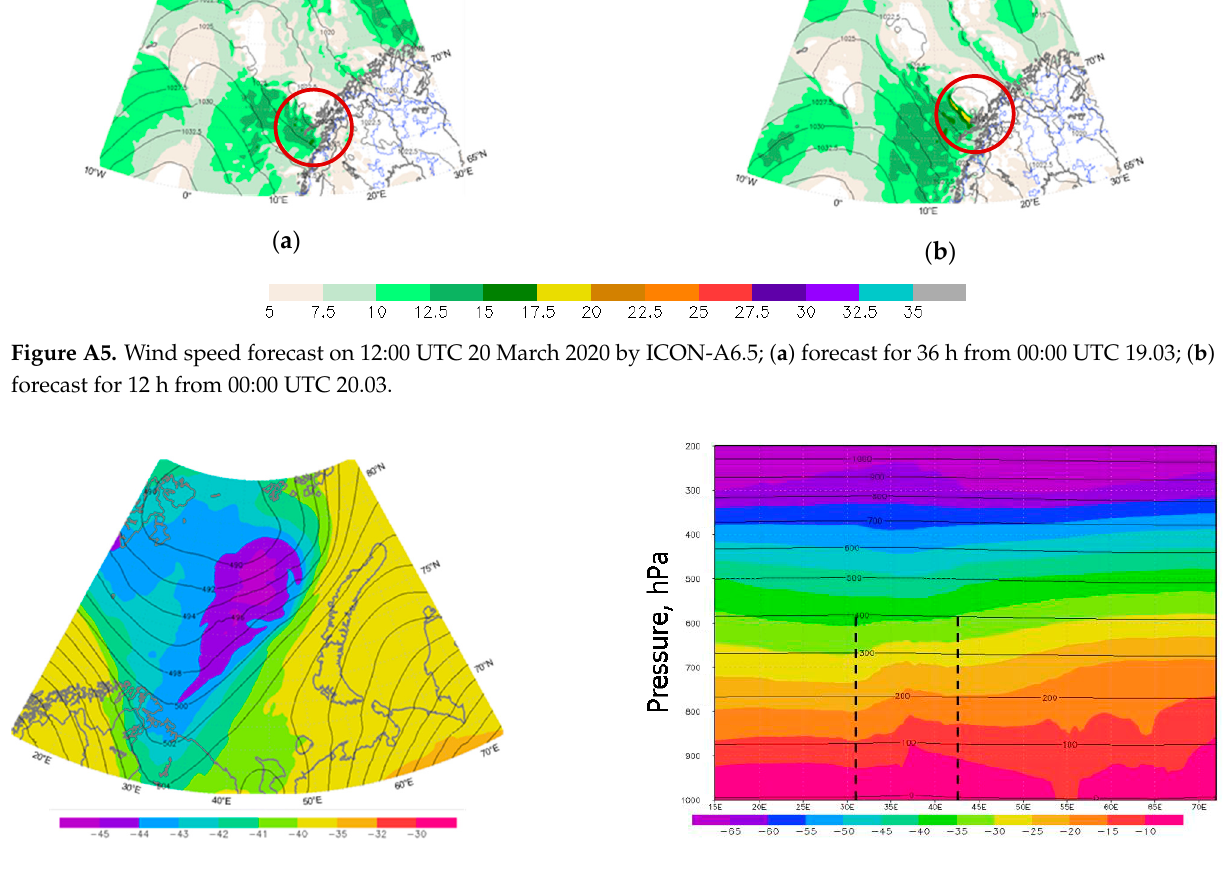
Figure A4. ICON ‐ A6.5: wind speed at H500. Valid time 04:00 UTC 26 February 2020.